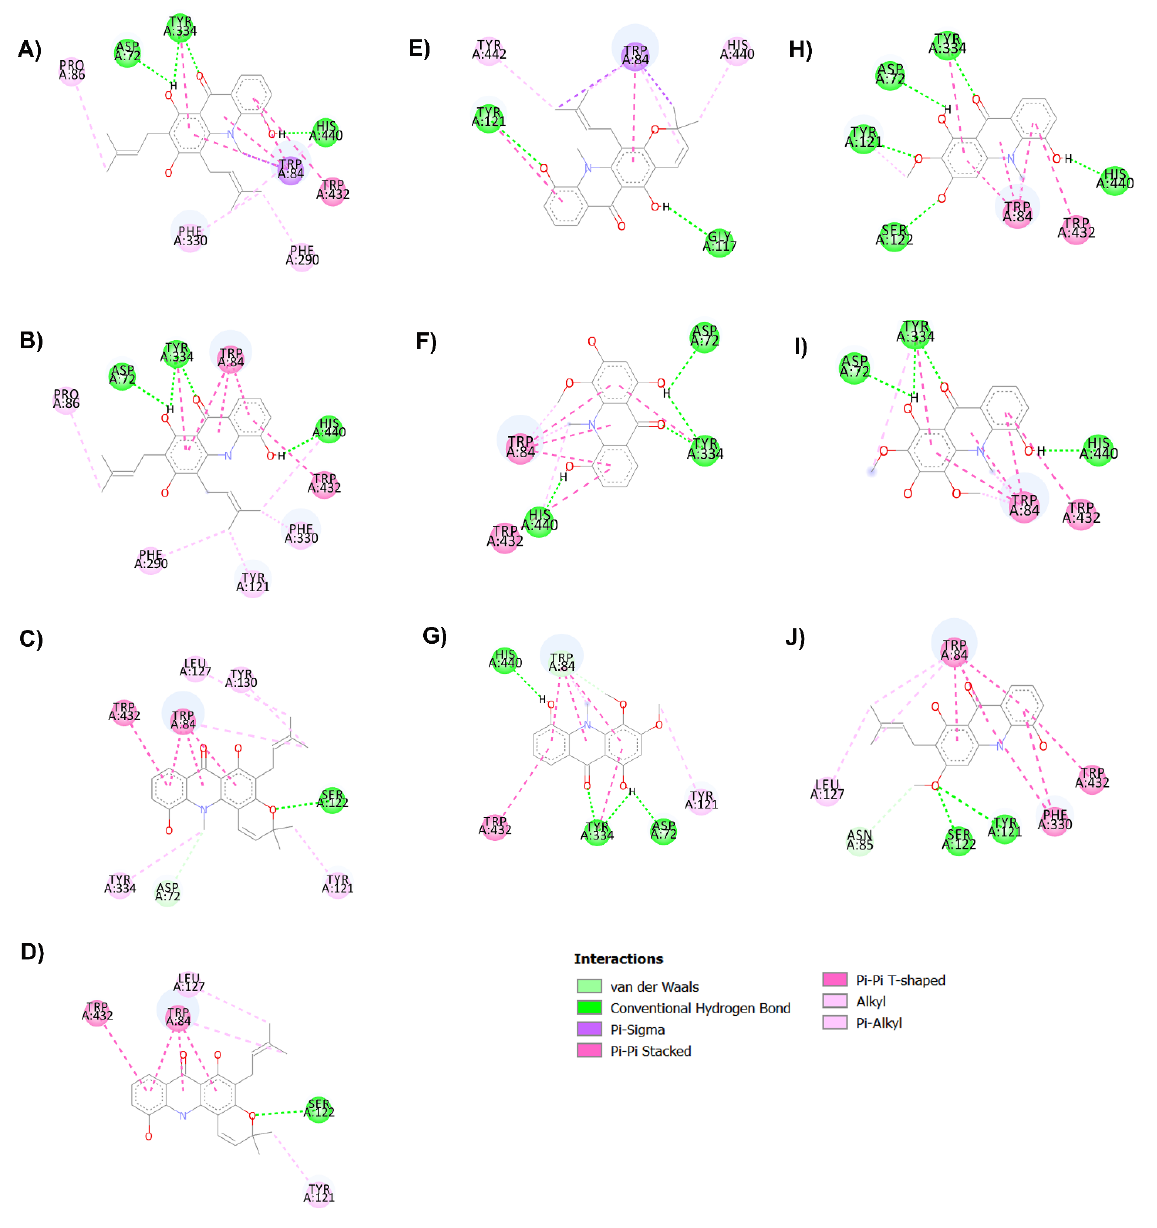
Figure 3. Binding interaction diagram of acridone derivatives N-methylatalaphylline ( A ), atalaphylline ( B ), N- methylatalaphyllinine ( C ), atalaphyllinine ( D ), N-methylcycloatalaphylline A ( E ), citrusinine II ( F ), citrusinine I ( G ), glycosparvarine ( H ), citruscridone ( I ), and buxifoliadine C ( J ) bound to